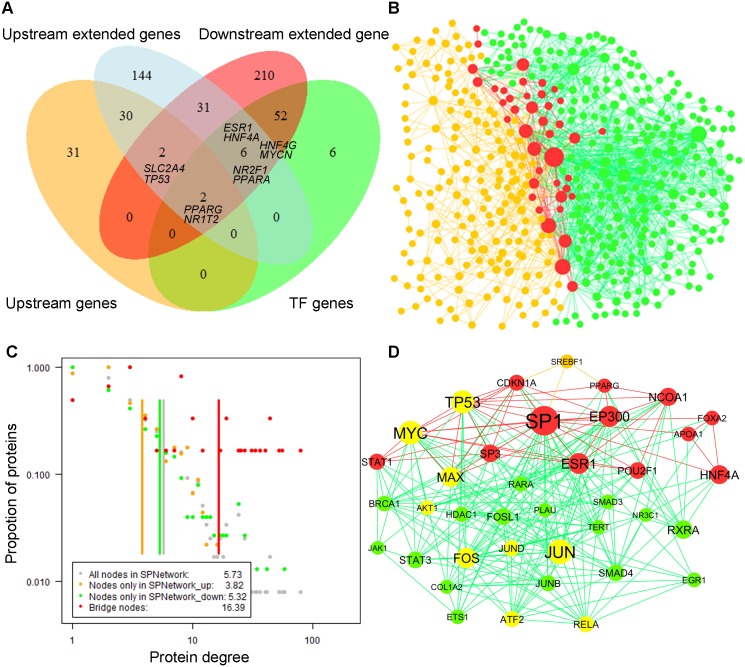
Metformin-specific signaling pathway network (SPNetwork).A) A four-way Venn diagram summarizes the number of shared genes among metformin upstream genes represented by ‘Upstream genes’, metformin downstream genes (‘TF genes’), metformin upstream extended genes in the metformin upstream network (‘Upstream extended genes’), and metformin downstream extended genes in the metformin downstream network (‘Downstream extended genes’). B) Metformin-specific SPNetwork with 477 nodes and 1366 edges. The nodes and edges in orange correspond to nodes and edges only in the metformin upstream network. The nodes and edges in green correspond to the nodes and edges only in the metformin downstream network. And the nodes and edges in red correspond to the nodes and edges common to the metformin upstream network and the metformin downstream network. C) Degree distributions and average degrees (vertical lines) of the four gene sets in the metformin-specific SPNetwork. The four gene sets are 41 common nodes, 174 nodes only in the metformin upstream network (SPNetwork_up), 262 nodes only in the metformin downstream network, all 477 nodes in the metformin-specific SPNetwork (SPNetwork_down). The Y-axis represents the proportion of proteins having a specific degree. D) The subnetwork of the 38 hub nodes extracted from metformin-specific SPNetwork. The legends for orange nodes and edges, red nodes and edges, and green nodes and edges are same as those in the subFig B. The nodes in yellow correspond to the genes that exist in the pathway ‘MAPK signaling pathway’ according to KEGG annotation.